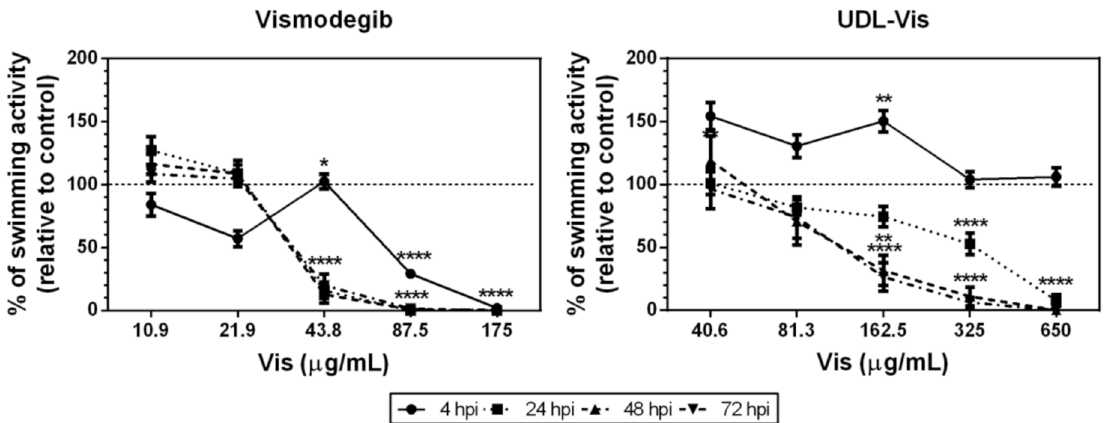
Figure 12. Percentage of spontaneous swimming activity of larvae treated with UDL-Vis and free Vismodegib with respect to the corresponding control (dotted line indicates 100% swimming activity), at 4, 24, 48, and 72 h post-incubation (hpi). Data are shown as mean ± SEM ( n = 24). * p < 0.05, ** p < 0.01, **** p <